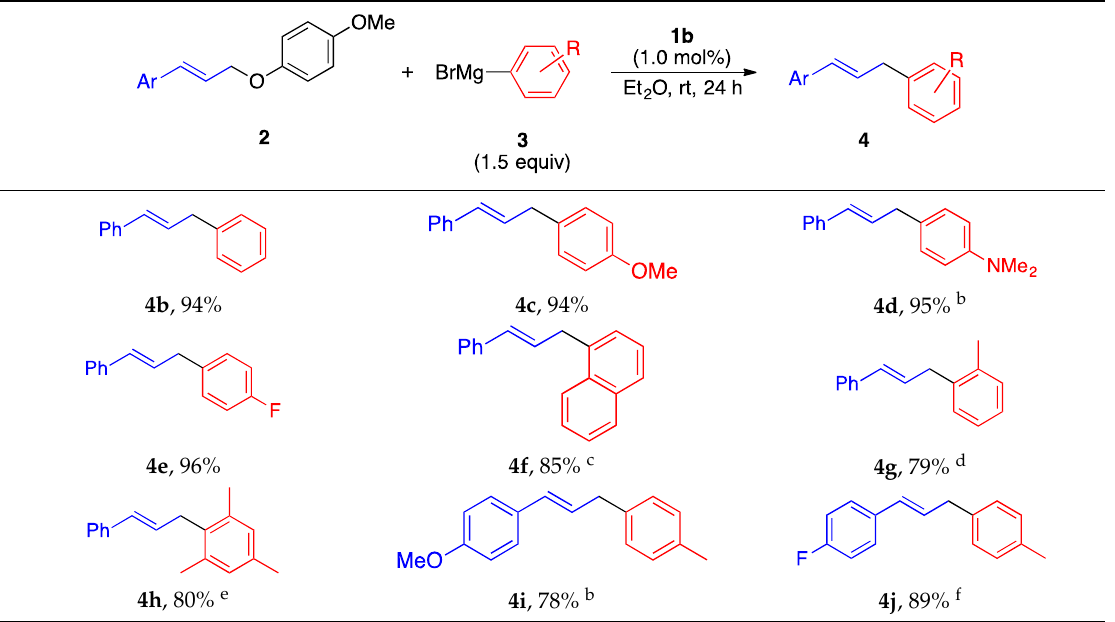
Table 4. The cross-coupling reaction of allylic ethers 2 with arylmagnesium reagents 3 . a